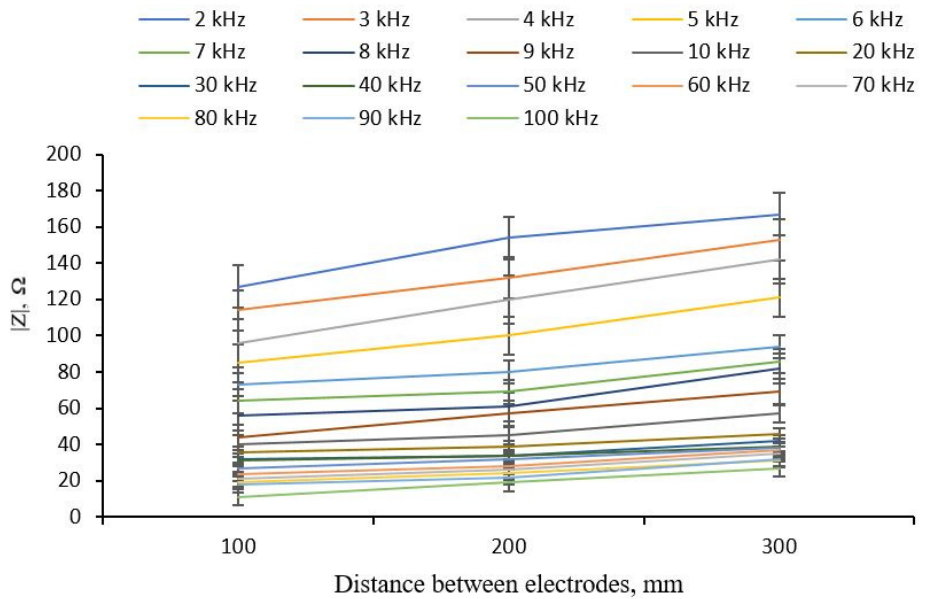
Figure 4. Dependence of the impedance modulus on the distance between the electrode fixed on the pear tree.